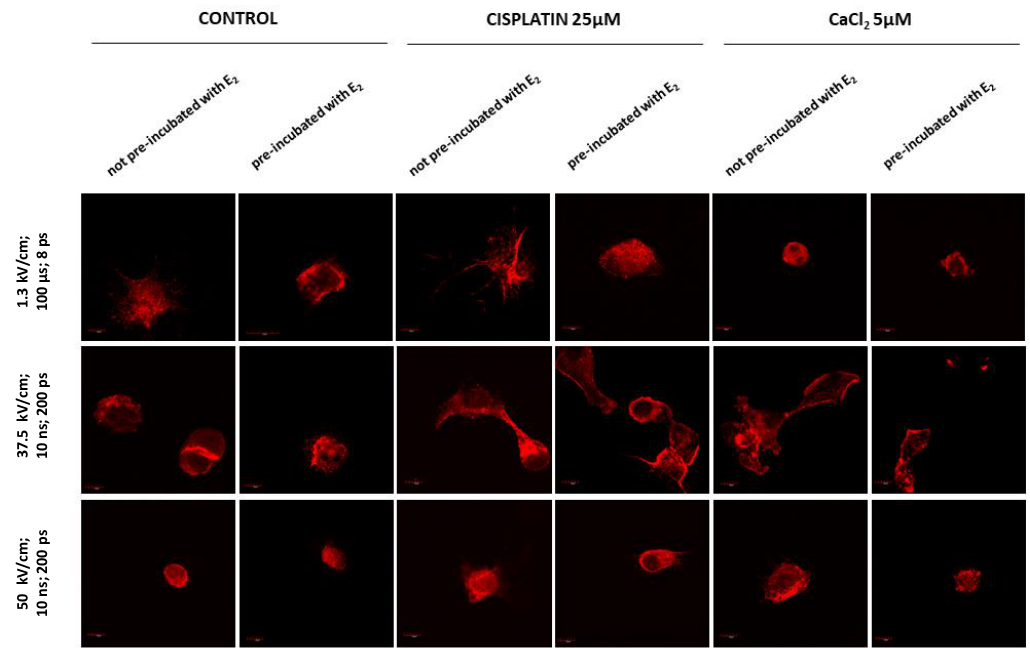
Figure 6. Immunofluorescence staining of MDAH-2774 cells (60 × ) after µ EP and nsEP with the addition of cisplatin and CaCl 2 . Alexa Fluor TM 546 phalloidin used for actin filaments labeled. Scale bars represent 100 µ m; ps — pulses.